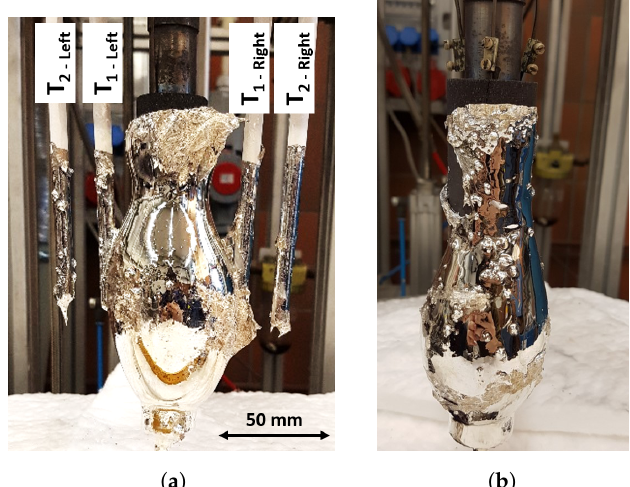
Figure 3. ( a ) Crystallized aluminum with the thermocouples in ceramic protective tubes, used for determination of horizontal temperature gradient, and ( b ) crystallized aluminum for the trial to measure the vertical temperature